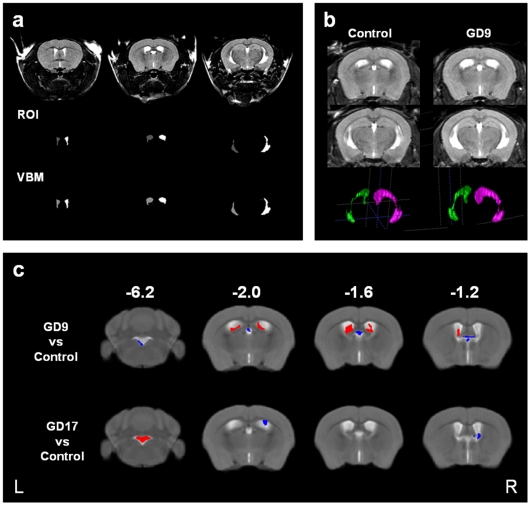
CSF space quantified using VBM and ROI methodology.
a. Overlap in lateral ventricles quantified using voxel-based morphometry (VBM) and region-of-interest (ROI) methodology showing an animal with the lowest agreement (Dice = 0.92 both sides) between the manual delineation and automatic segmentation of ventricles. Left ventricle in grey; right ventricle in white. b. Region-of-Interest defined lateral ventricles. Raw images and the 3D rendered lateral ventricles of a mouse from the control and one from the GD9 group. c. Voxel-wise analyses of CSF in adult mice exposed to prenatal challenge at GD9 compared to control and GD17 compared to control. Red indicates a significantly greater likelihood of finding CSF; Blue indicates a significantly lower likelihood of finding CSF.